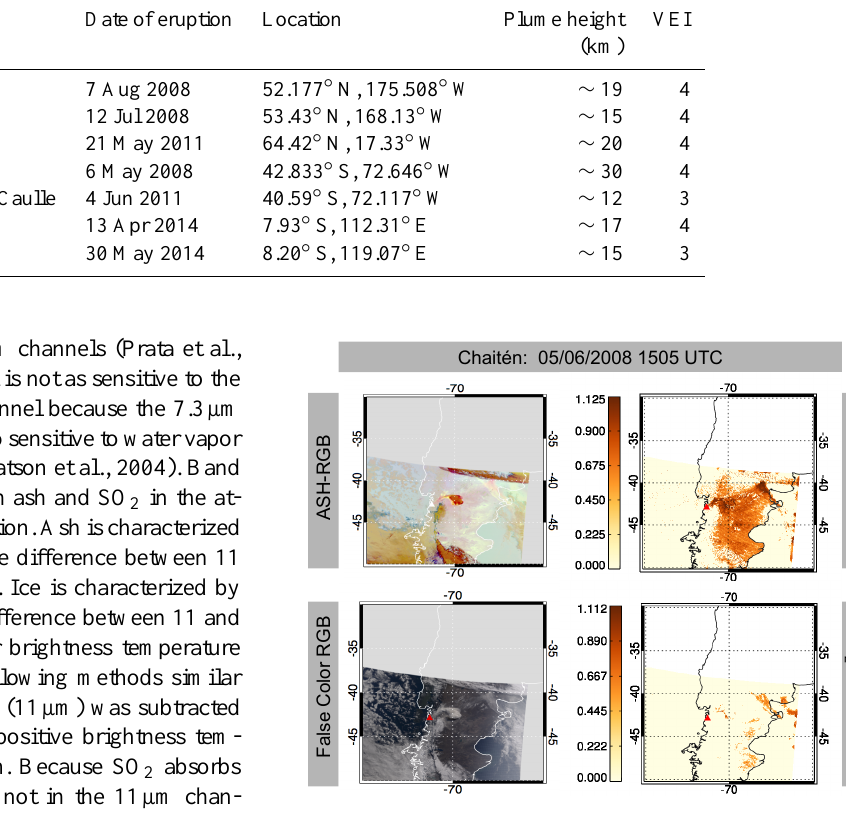
Figure 1. (Top left) Ash-RGB created using MODIS infrared bands 32–31, 31–29, and 31 for the eruption of Chaitén, 6 May 2008, 1505Z; (bottom left) false color RGB image created using MODIS reflective bands 1, 4, and 3 for the same eruption and time; (top right) ash-detection neural network output for the same eruption and time; (bottom right) SO 2 -rich-ash-detection neural network output for the same eruption and